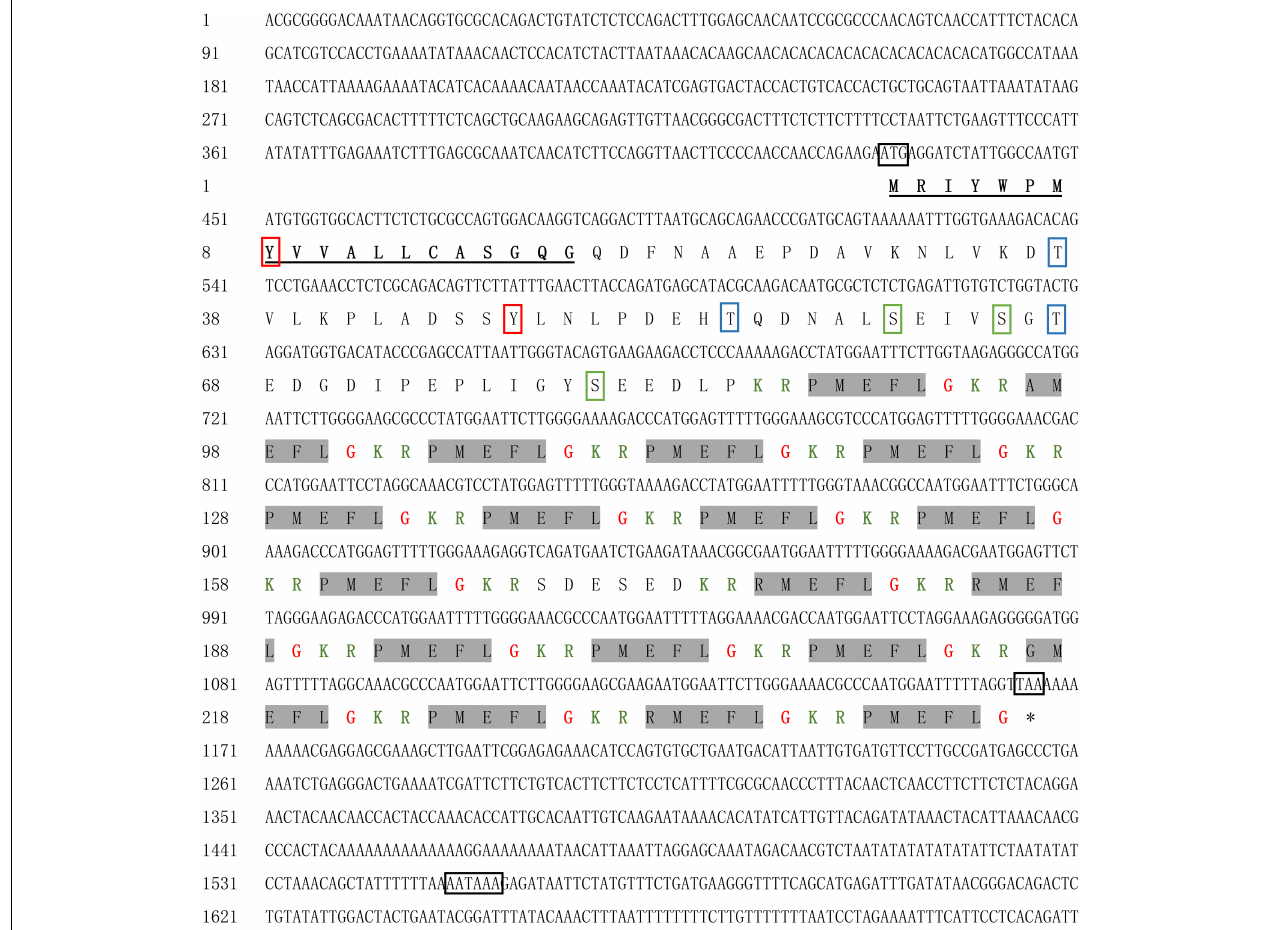
FIGURE 1 | Nucleotide sequence and deduced amino acid sequence of SjPRQFVRP . The initiation codon (ATG), stop codon (TAA), and polyadenylation signal (AATAAA) are boxed in black. The deduced signal peptide is underlined in black. The putative mature peptides are shaded in gray. The cleavage sites are identified in green color, and glycine used for C-terminus amidation is marked in red. The predicted phosphorylation sites are shown in colorful frames (Tyr site in red, Thr site in blue, and Ser site in green).